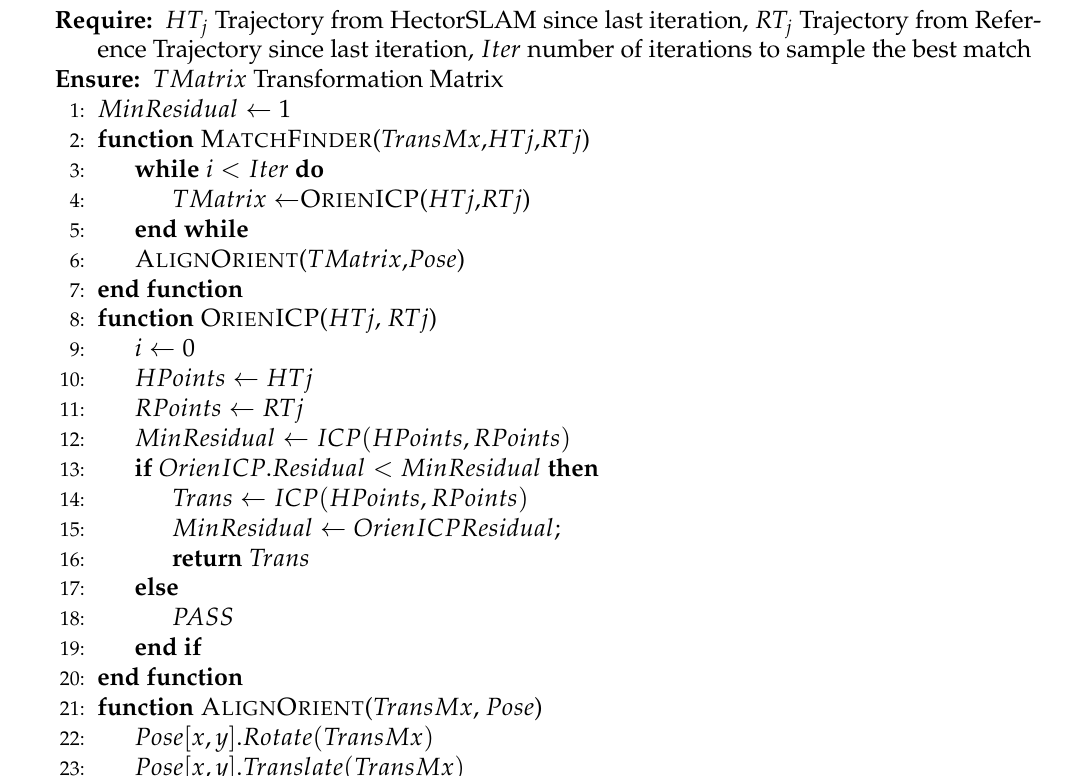
Algorithm 1 Map Orientation